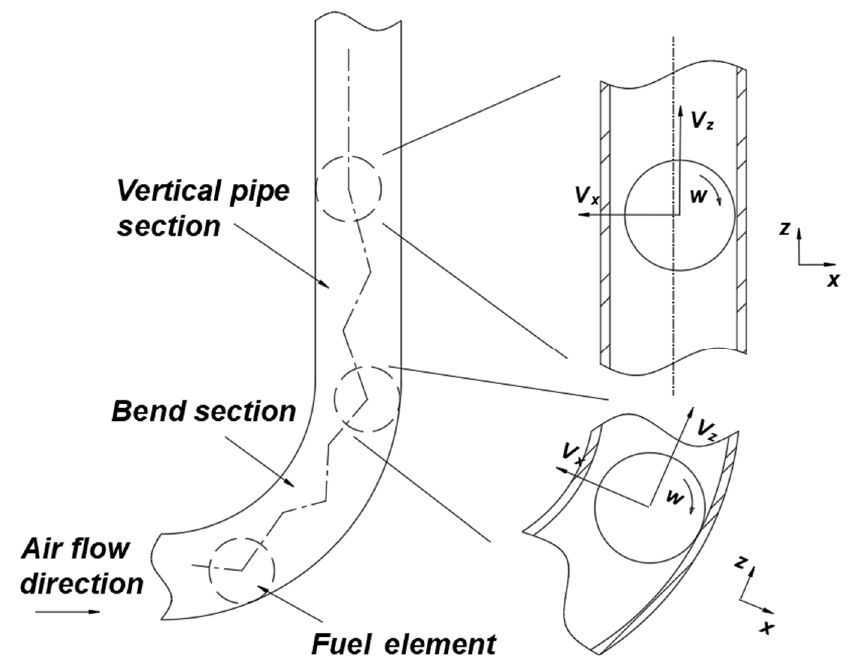
Figure 1. Movements of the fuel element in the pipe.